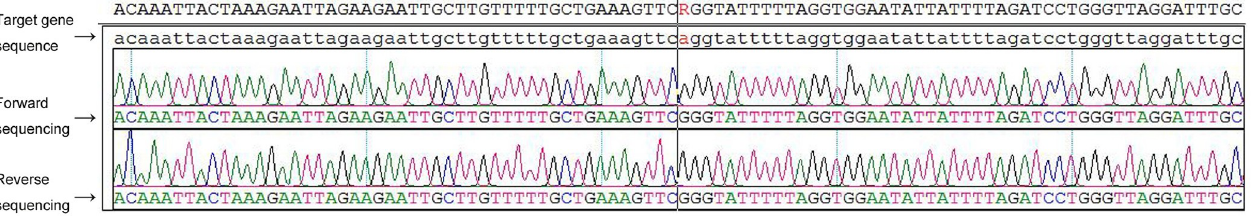
Fig 2. Sequence diagram of DHPS PCR amplification